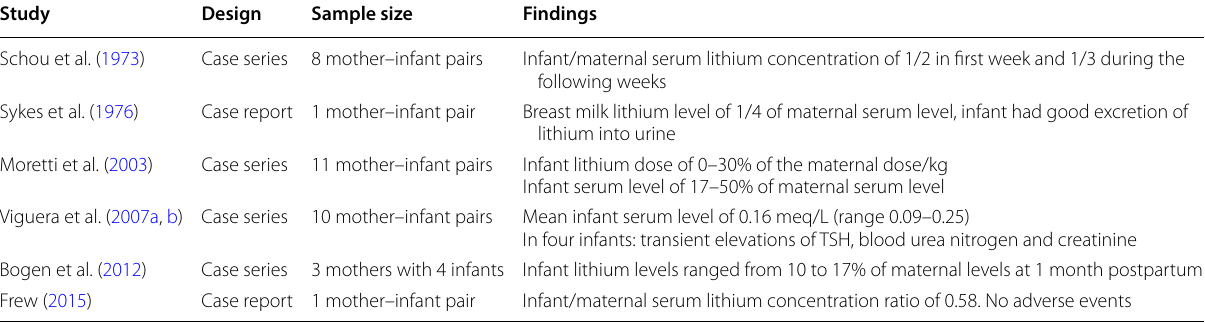
Table 5 Summary of the results from clinical studies on infant lithium exposure through lactation